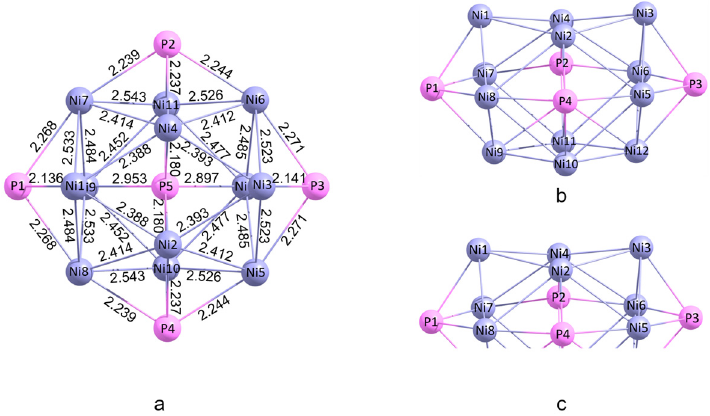
Figure 1. Ni 12 P 5 cluster model, pink and purple balls represent P and Ni atoms, respectively. ( a ) Top view; ( b ) side view; and ( c ) for brevity, the atoms out of the reaction site are not shown.